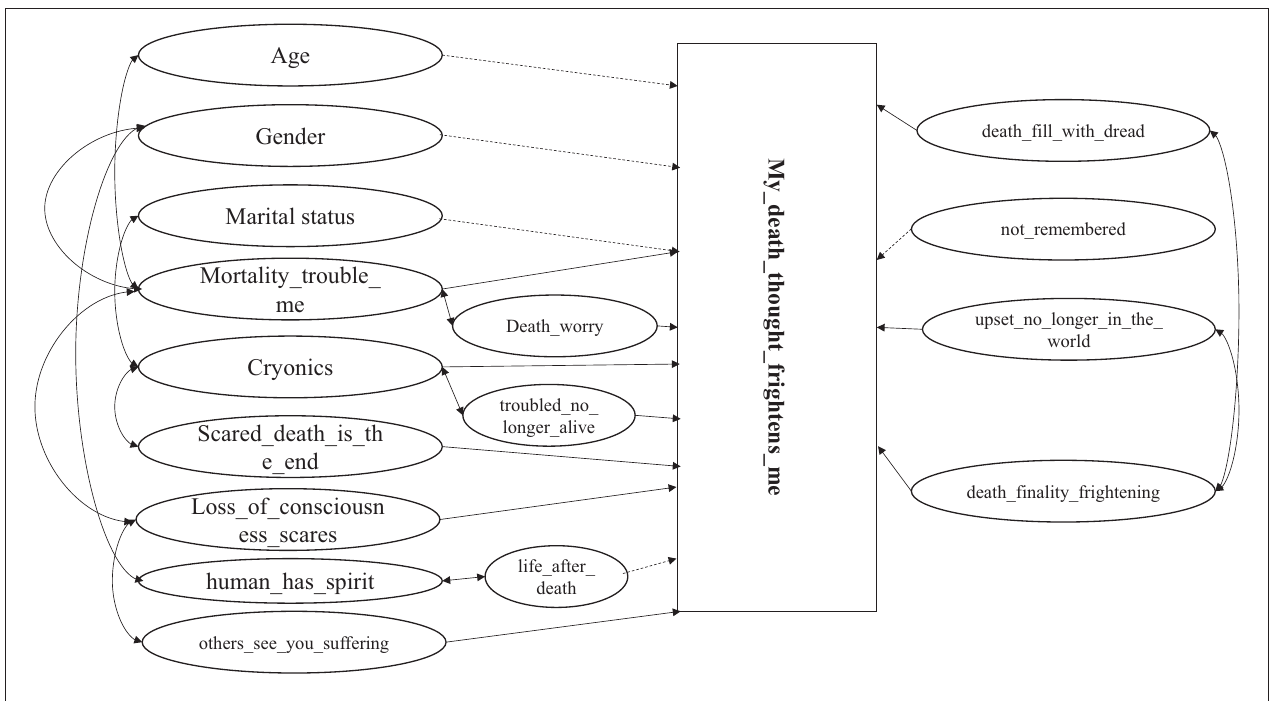
FIGURE 2 | Complex interaction between factors and their association with fear of death.